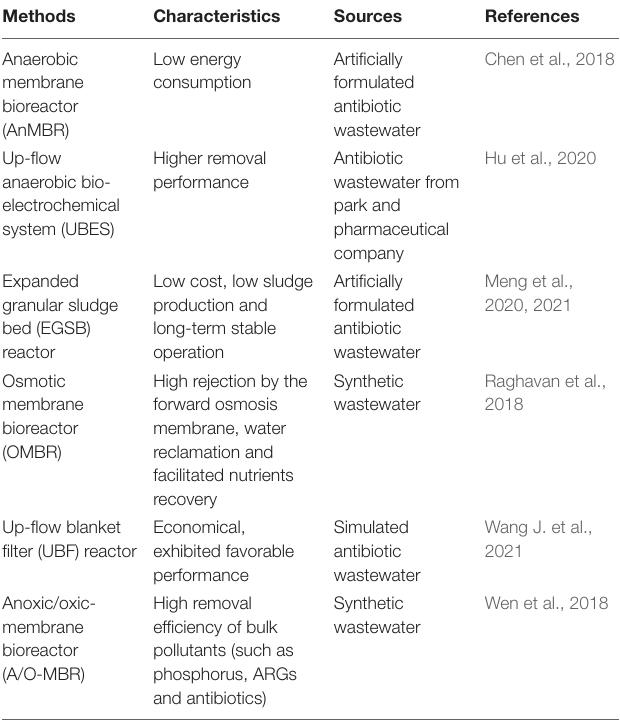
TABLE 3 | Diverse reactors to treat antibiotic wastewater.